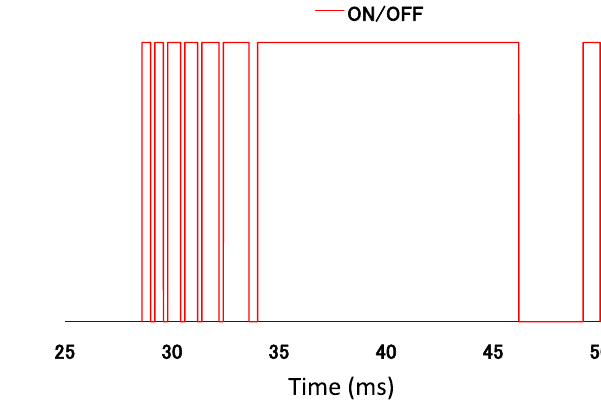
FIG. 17. (a) Ideal and simulated voltage patterns and (b) the discrepancy between both. FIG. 18. Time table of Switch